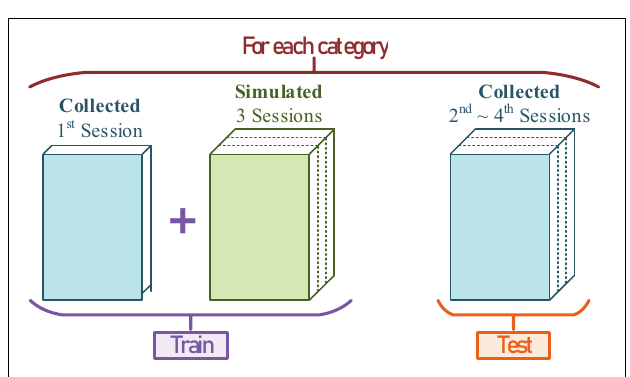
FIGURE 19 | The division of training-sets and testing-sets for each